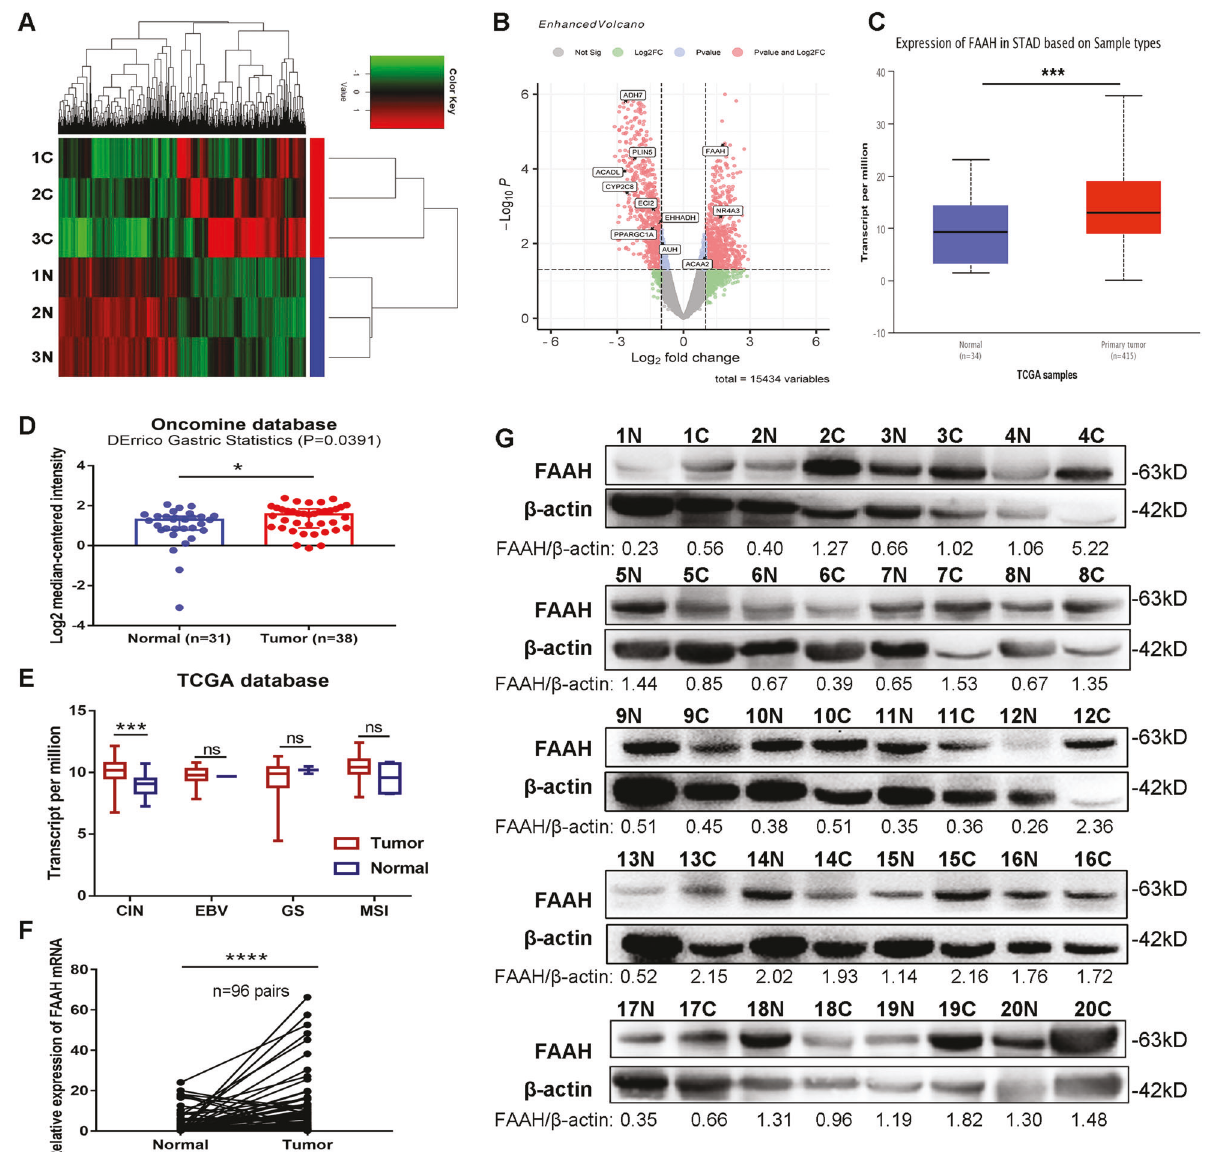
Fig. 1 FAAH is highly expressed in GC tissues. A Clustered heatmap. Each row represents a tissue sample, and each column represents a coding gene. B Volcano plots. The red points on the right indicate the differentially upregulated genes with statistical signi fi cance while the red points on the left indicate the downregulated genes. Differential expression of FAAH in tissues from C TCGA database and D Oncomine database. E Differential expression analysis of FAAH in 4 GC subtypes (data from TCGA). F mRNA levels of FAAH in 96 pairs of GC tissues. G Protein levels of FAAH in 20 pairs of GC tissues. * p < 0.05, *** p < 0.001, **** p < 0.0001. N non-cancerous tissue, C cancerous tissue, CIN tumours with chromosomal instability, EBV tumours positive for Epstein-Barr virus, GS genetically stable tumours, MSI microsatellite unstable overexpressing miR-1275 was decreased compared to that of correlation analysis disclosed a negative correlation between miR- the control group, while that of HGC-27 cells with downregulated 1275 and FAAH in GC tissues (Fig. 4G). miR-1275 was increased. Functional tests showed that over- Our previous results showed that the expression of FAAH was expression of miR-1275 could slow down the proliferation rate, elevated in three GC cell lines relative to the normal controls, with reduce clonal colonies formation and the proportion of proliferat- the highest expression level in MKN-1 cells and a relatively low ing cells, inhibit cell metastasis, and induce apoptosis and cycle expression level in HGC-27 cells (Fig. 2A, B). Considering that miR- arrest; while miR-1275 inhibitor exerted a promoting effect on the 1275 is an upstream regulator of FAAH, to verify whether miR- malignant phenotype of GC cells (Supplementary Fig. S3d – j). 1275 can reverse the effect of FAAH on cell phenotype, we inhibited miR-1275 in HGC-27 cells with a stable knockdown of miR-1275 partially reverses the cancer-promoting effects of FAAH, and a miR-1275 mimic was added to MKN-1 cells FAAH overexpressing FAAH (Supplementary Fig. S3b). As shown in By co-transfecting the miR-1275 mimic and FAAH overexpression Supplementary Fig. S3c, miR-1275 could indeed regulate the vector (pcFAAH) into MKN-1 cells, we found that the miR-1275 expression of FAAH. FAAH expression in MKN-1 cells